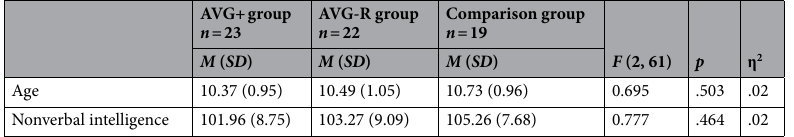
Table 4. Baseline comparisons for age and non-verbal intelligence for intervention and comparison